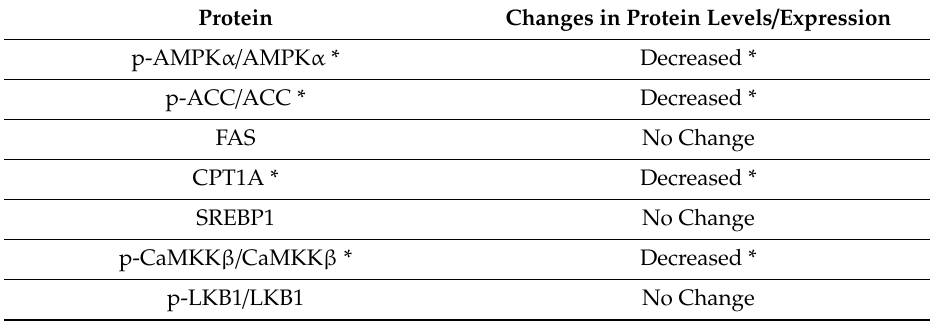
Table 2. Expression of proteins involved in AMPK α signaling in livers of ADH − deer mice fed 3.5% EtOH versus pair-fed